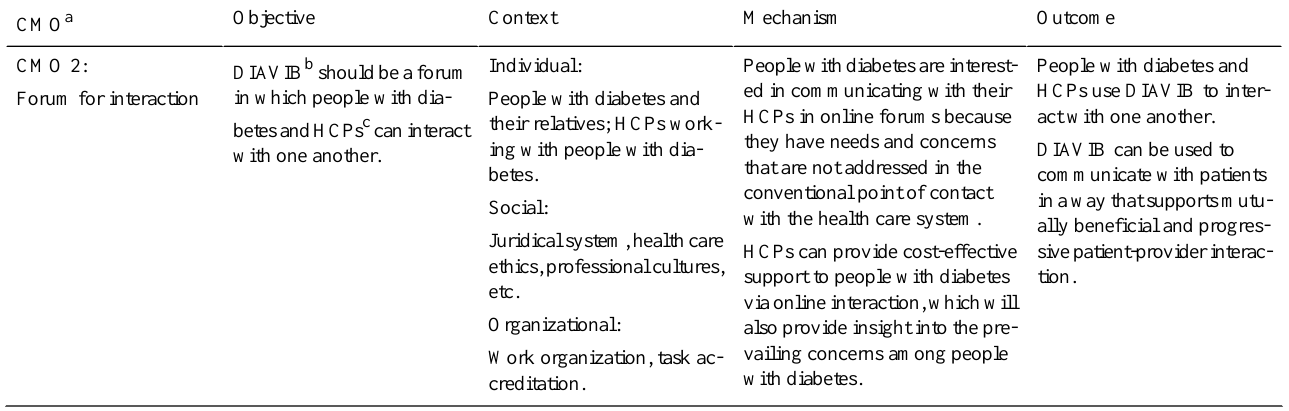
Table 3. Context-mechanism-outcome configuration 2: forum for patient-provider